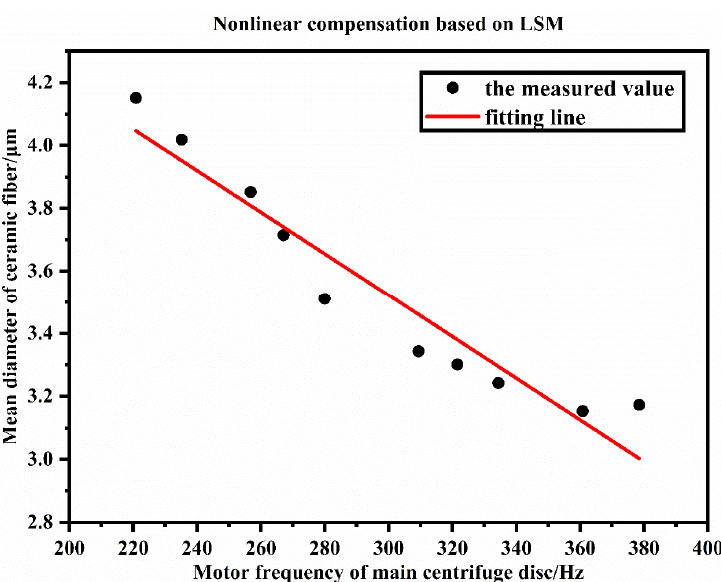
Figure 4. Diameter distribution of 100 ceramic fibers.